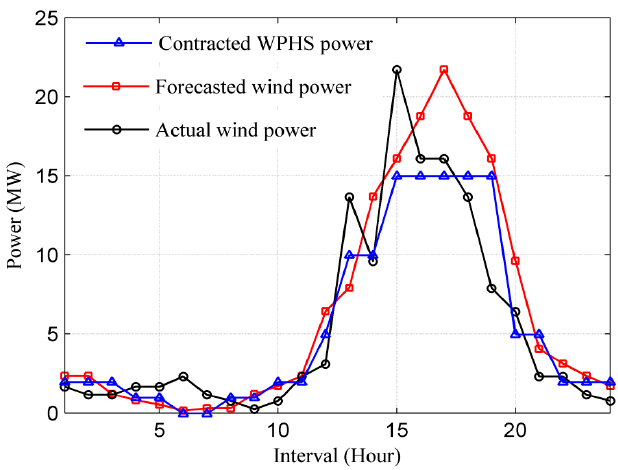
Figure 2. Actual, forecasted, and contracted wind power for 24 h scheduling period.